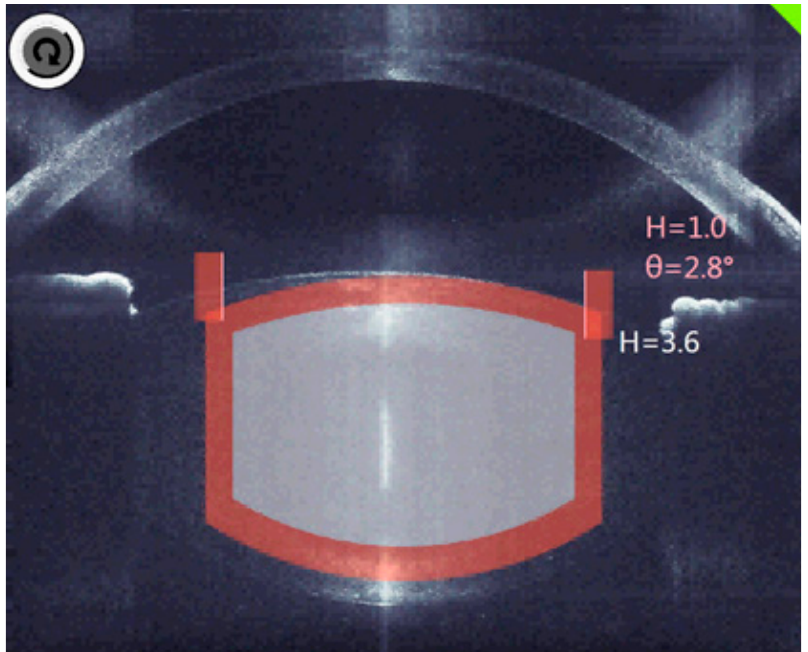
Figure 3. The planned cutting lines and areas are marked grey, the red bars are the calculated safety distances.